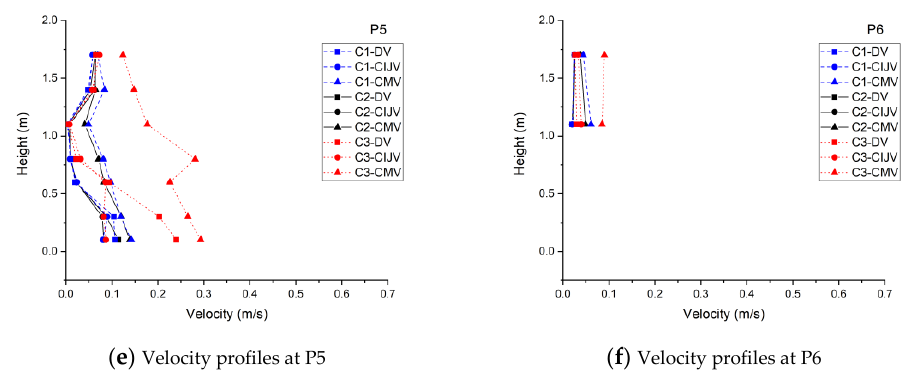
Figure 4. Velocity profiles at positions P1 ( a ), P2 ( b ), P3 ( c ), P4 ( d ), P5 ( e ), and P6 ( f ) for all cases.